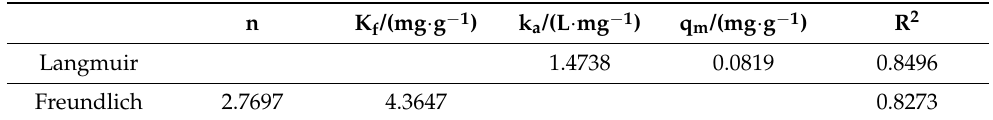
Table 2. Adsorption isotherm parameters of SAIEF.